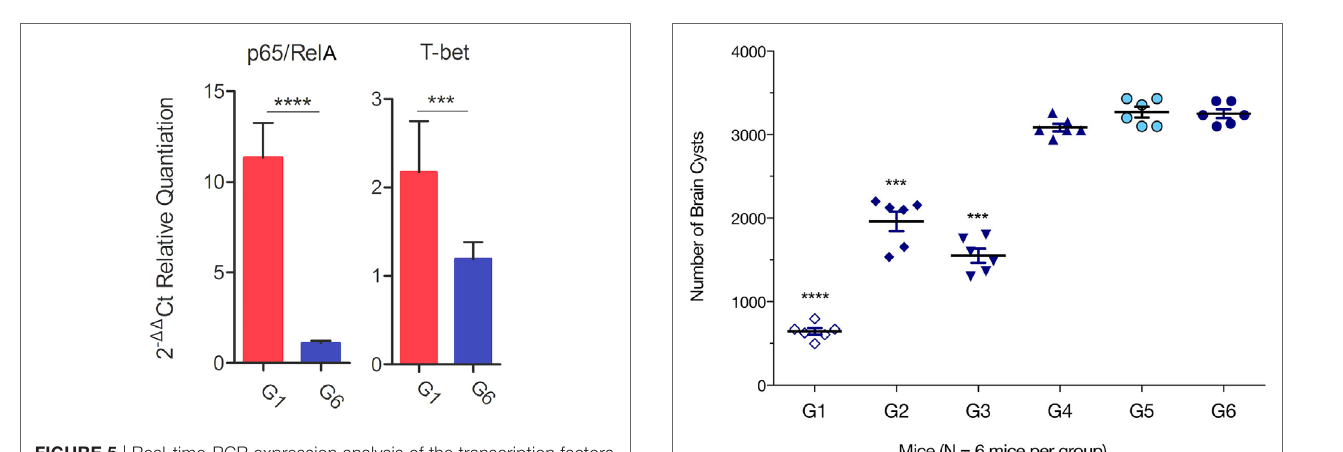
FigUre 5 | Real-time-PCR expression analysis of the transcription factors p65/RelA and T-bet. β -Actin was used as a housekeeping reference gene. Experimental groups include G1: mice received pVAX1 plasmids containing five antigens (ROP16, ROP18, MIC6, CDPK3, and PF); G6: healthy control mice. Each sample was analyzed in triplicate. Data are mean ± SDs (error bars) from the two mice. *** p < 0.001 and **** p < 0.0001.